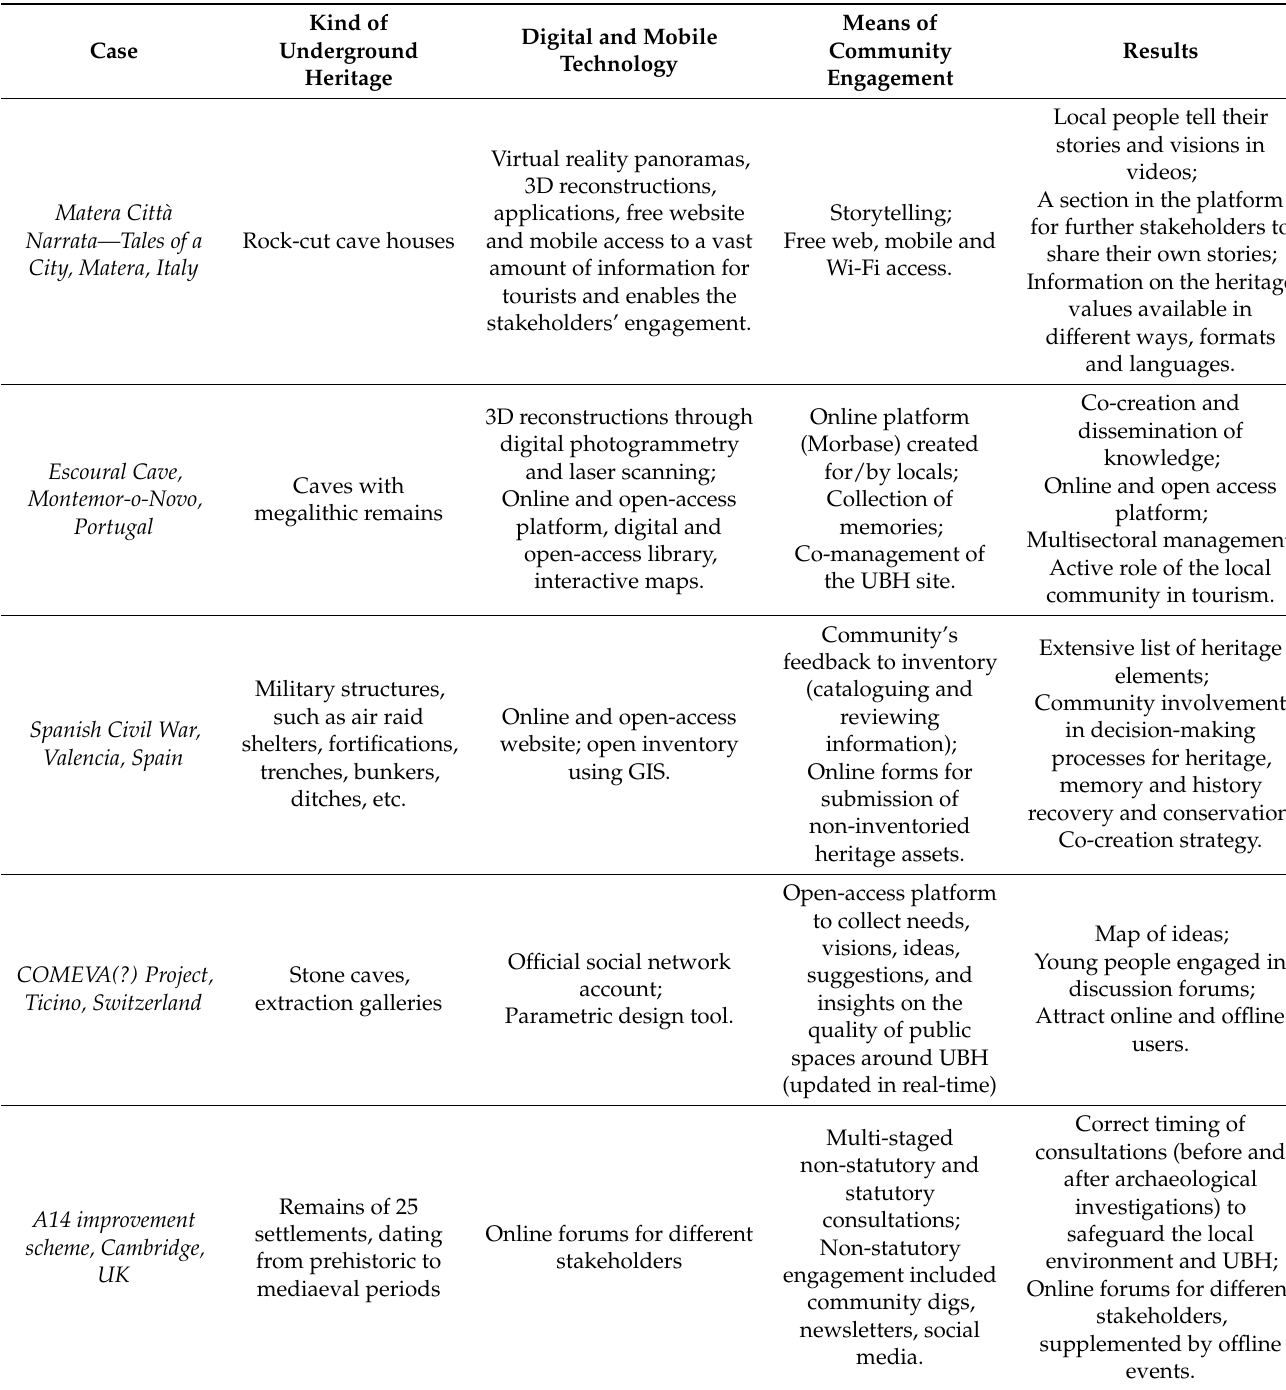
Table 1. Main characteristics of UBH activating—a brief